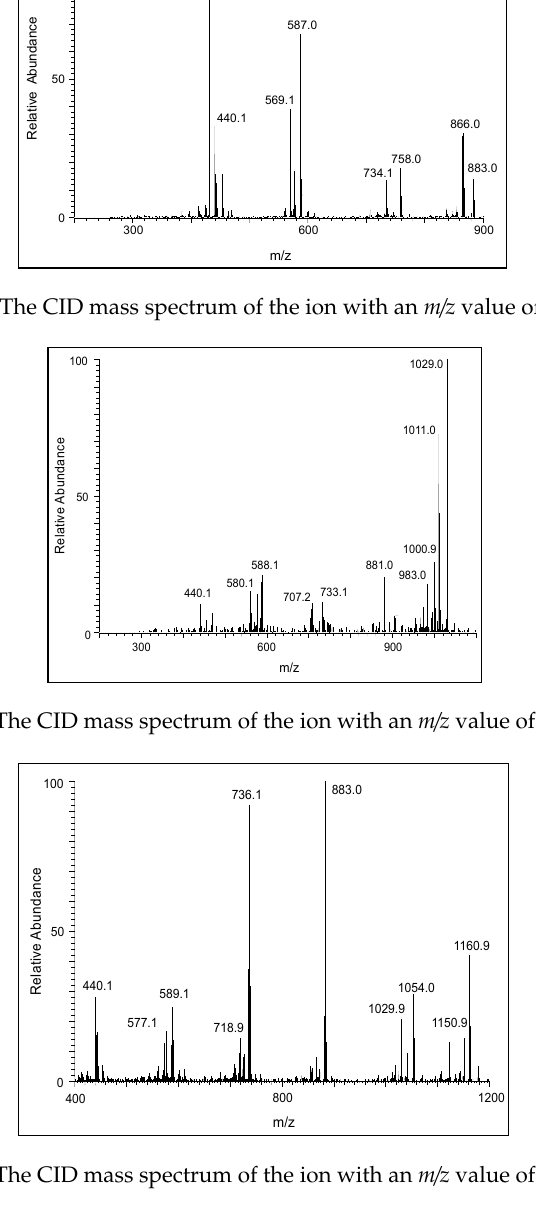
Figure 13. Proposed mechanism for the oxidative polymerization of DHI. DHI undergoes rapid aerial oxidation, producing DHI semiquinone radicals and the superoxide anion. Two molecules of DHI semiquinones undergo a redox reaction, regenerating DHI and producing the two-electron oxidation product that can exist in three different isomeric forms. Rapid condensation of these products generates dimeric, trimeric, and other oligomeric products at initial stages of oxidation. Eventually, they all condense and form insoluble black-colored eumelanin pigment.